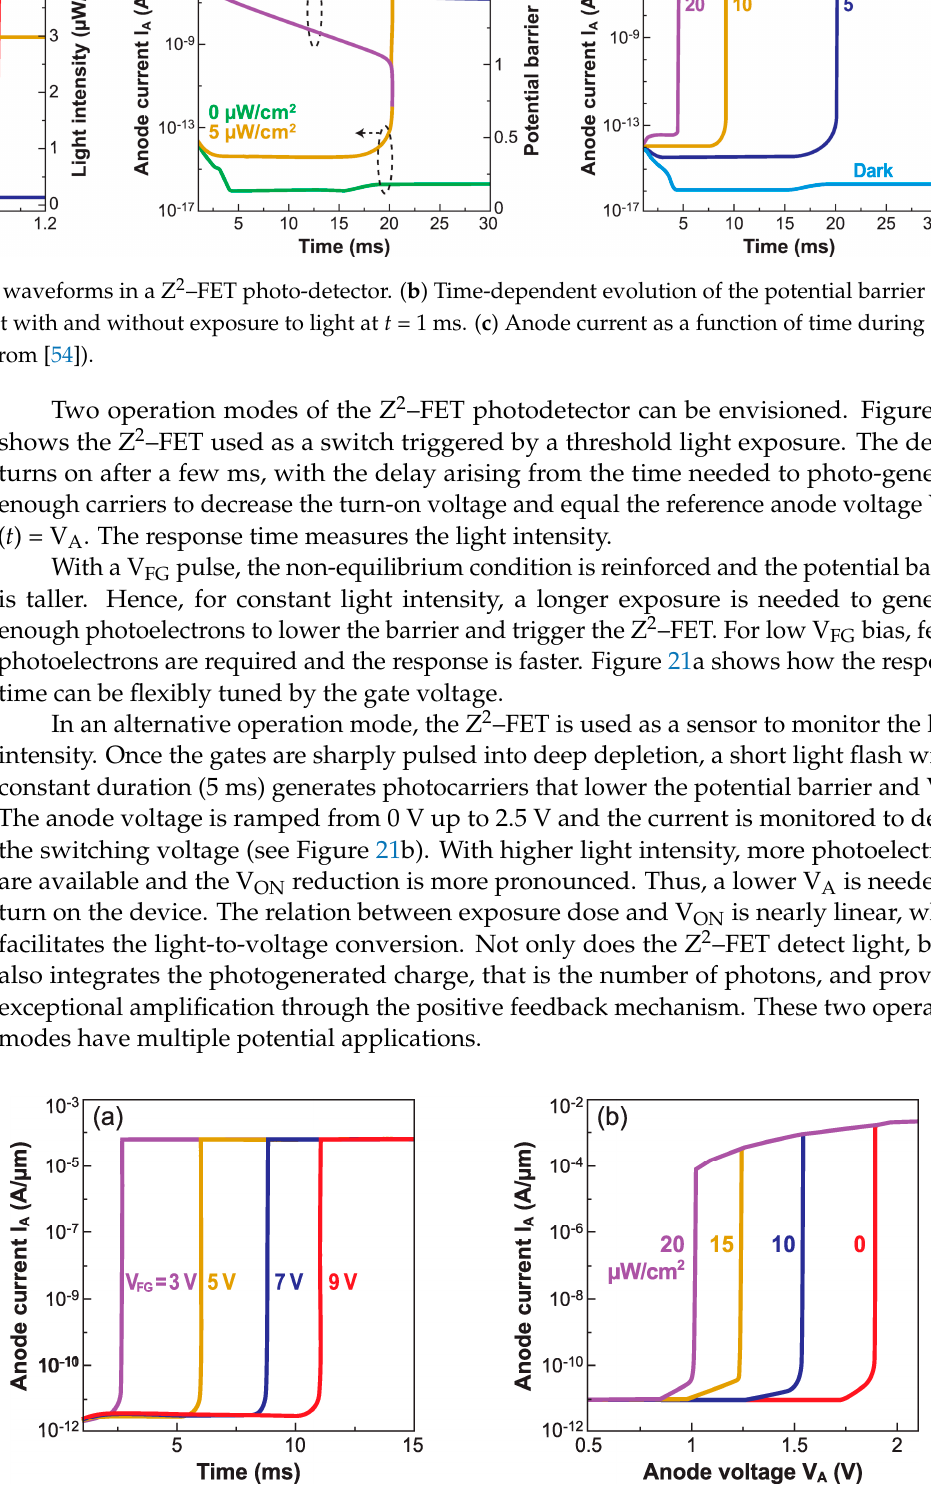
Figure 21. ( a ) Evolution of the anode current under exposure to continuous light for various gate voltages and V A = 1 V. ( b ) Turn ON characteristics of the Z 2 –FET for various intensities of light pulse (adapted from